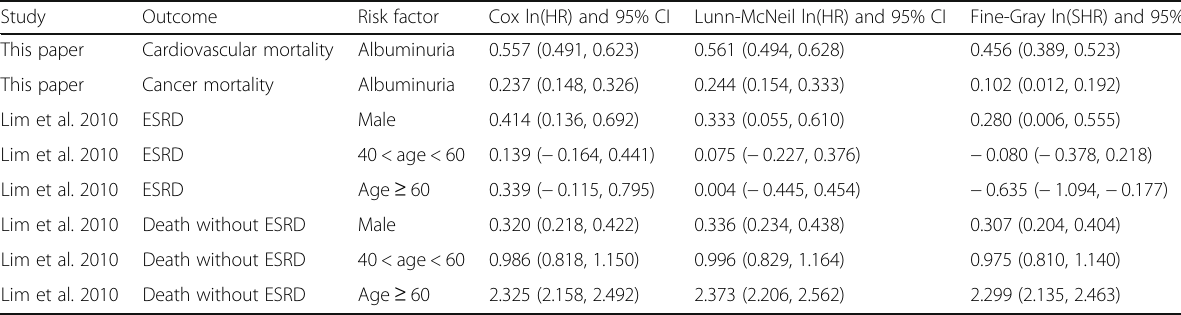
Table 4 Comparison between the results of this study and the study by Lim et al.